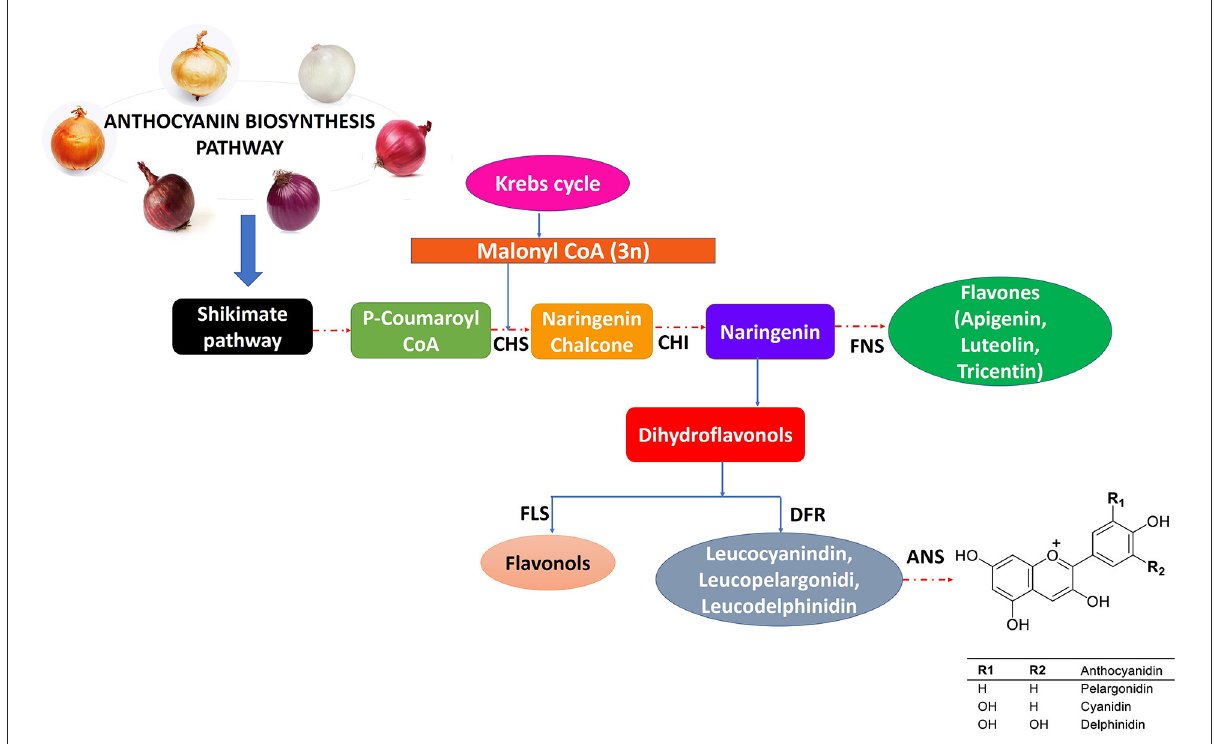
FIGURE1 Variety of onion colors and anthocyanins biosynthesis pathway regulated by different enzymes.